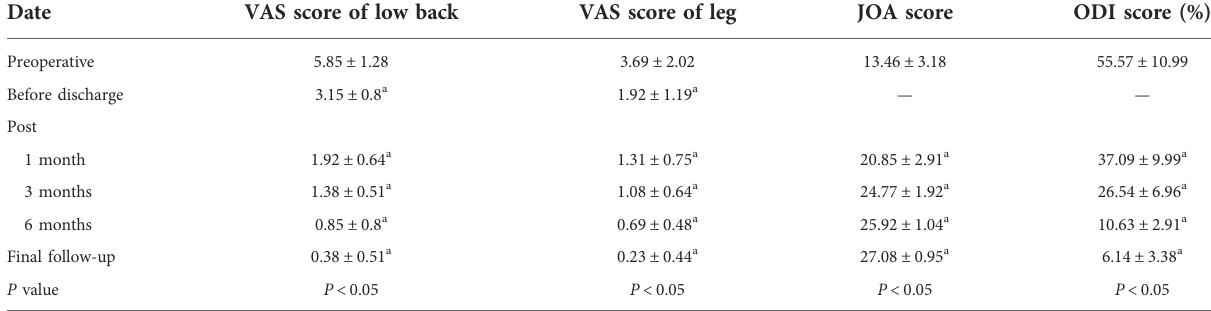
TABLE 5 Clinical outcomes (VAS, JOA, and ODI) of pre- and